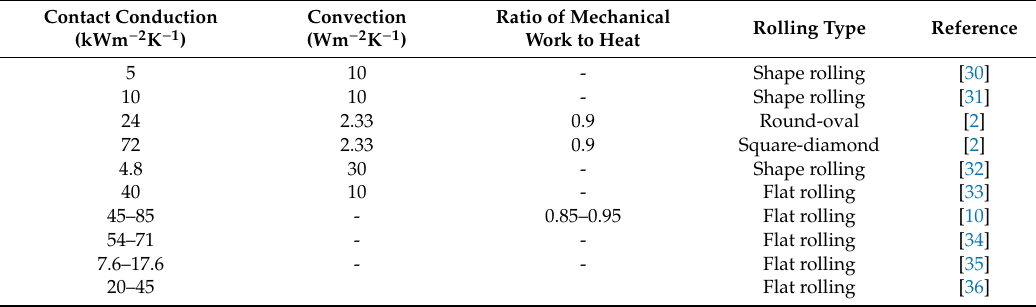
Figure 6. Schematic description showing the heat transfer mechanisms in a workpiece during the hot rolling process. Table 2. Process parameters and values for heat transfer during the hot rolling process.